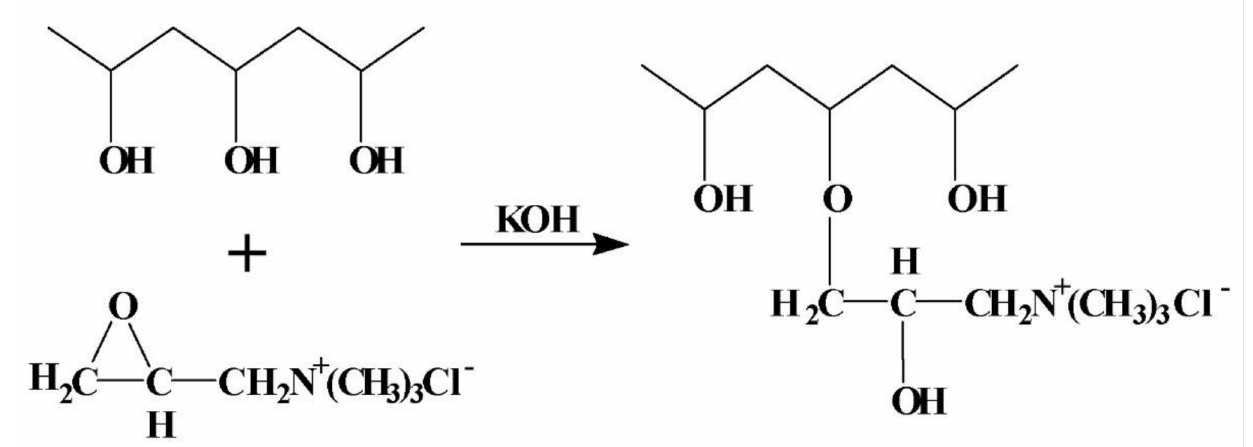
Figure 9. Chemical grafting of a quaternized group onto the PVA main chain (Reprinted with permission from ref. [120] Copyright 2008